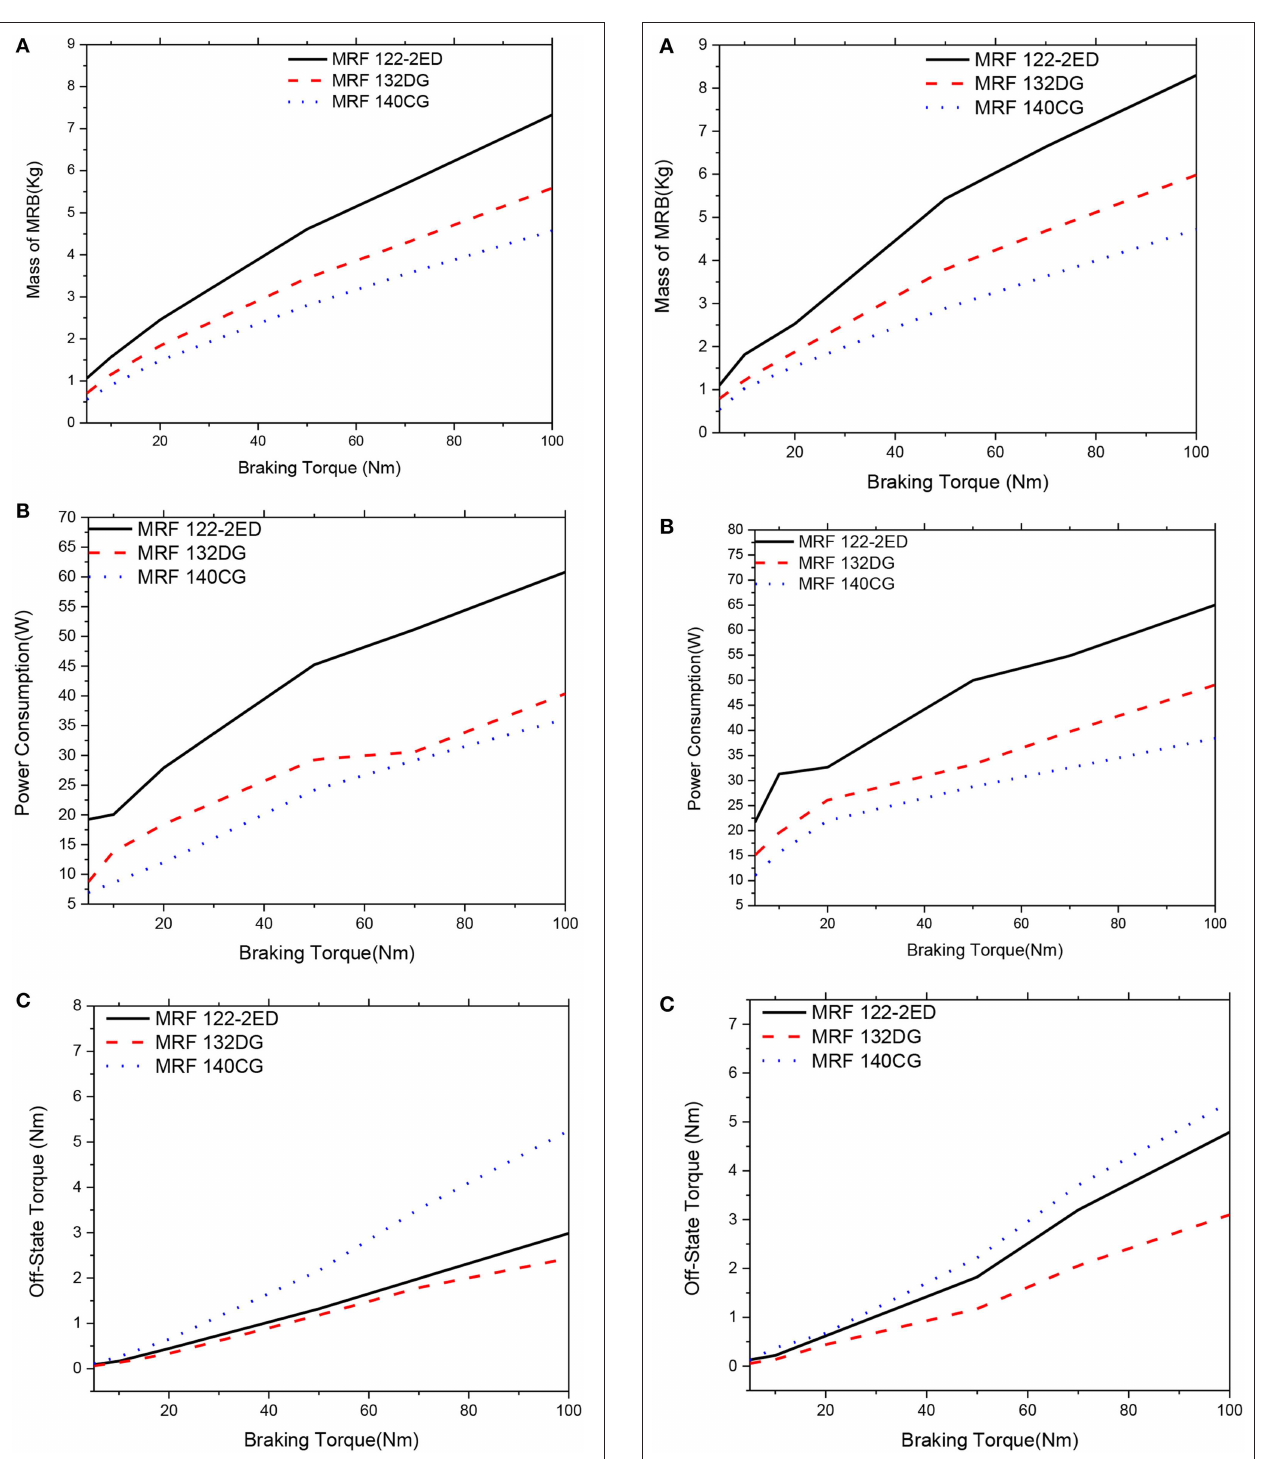
Frontiers in Materials |